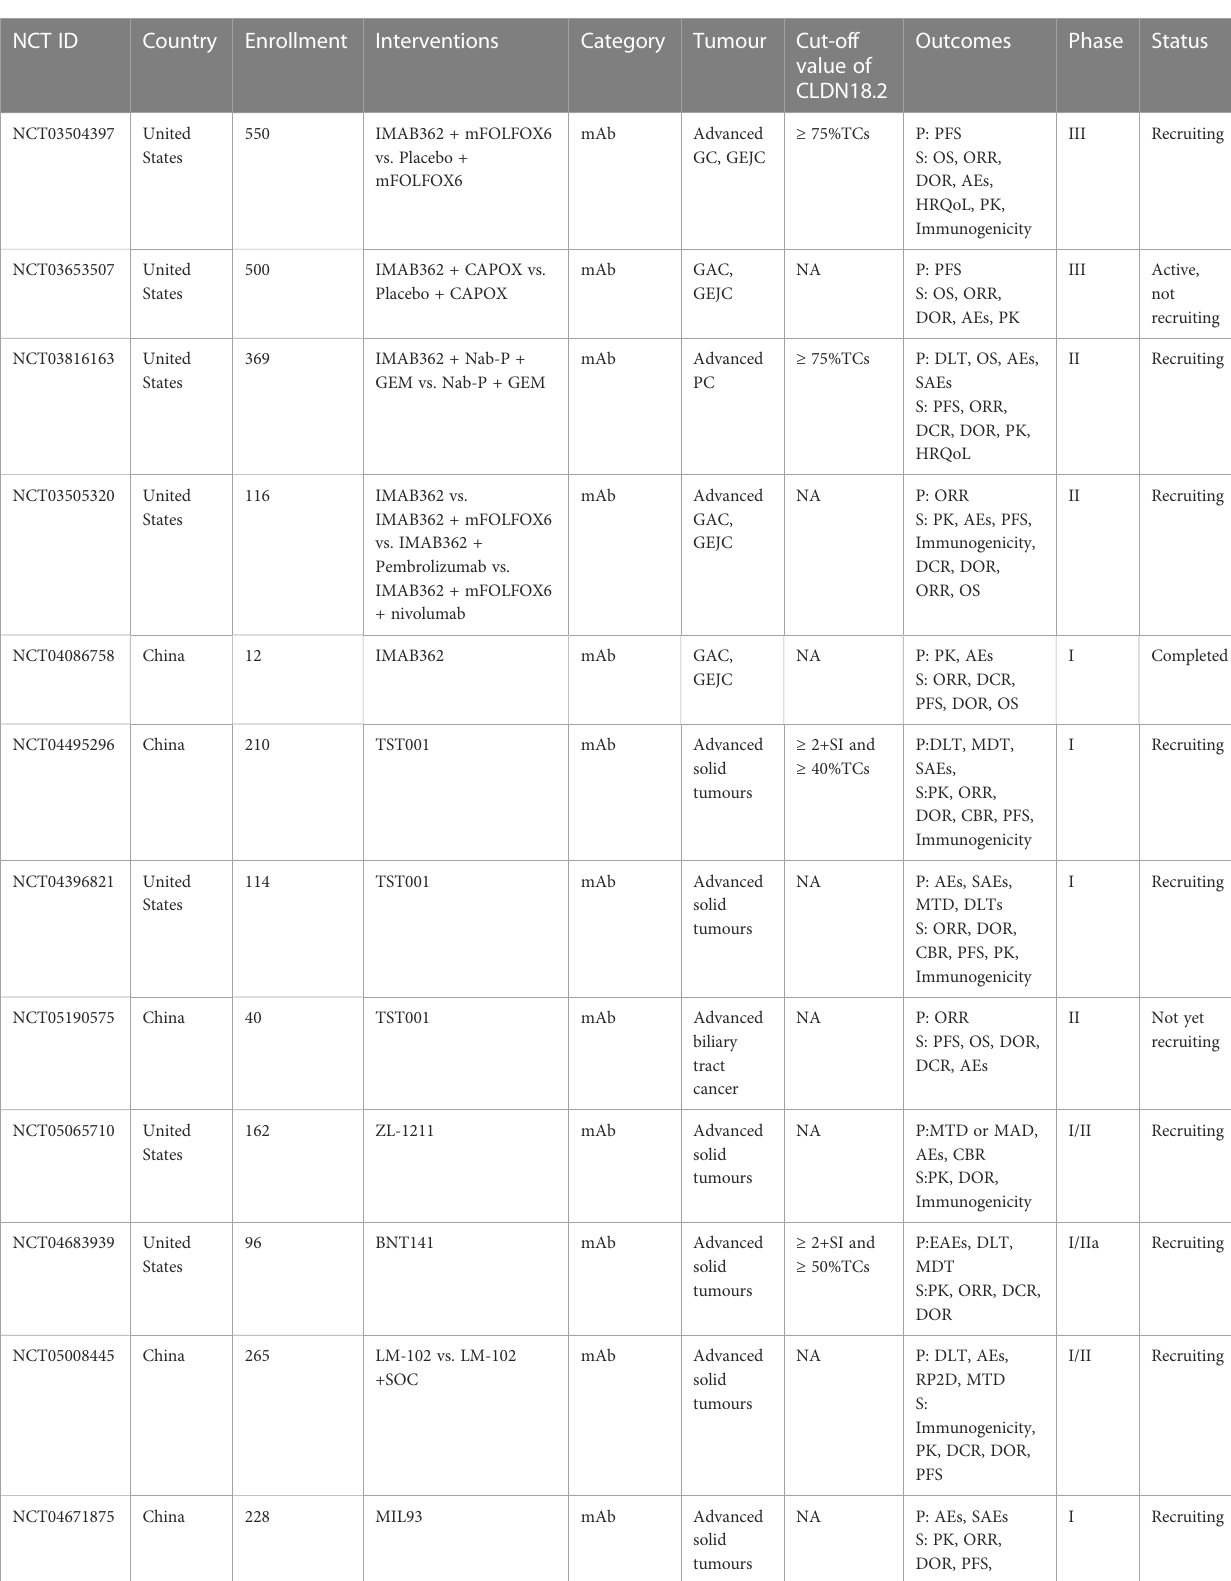
TABLE 3 Ongoing clinical trial of